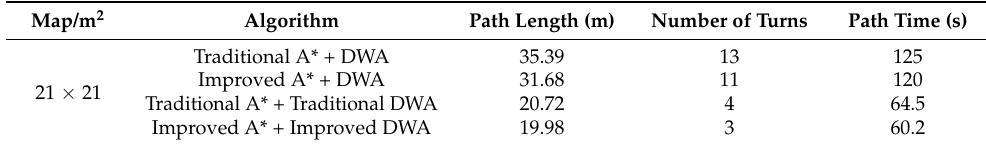
Table 2. Comparison of different algorithms’ performances.